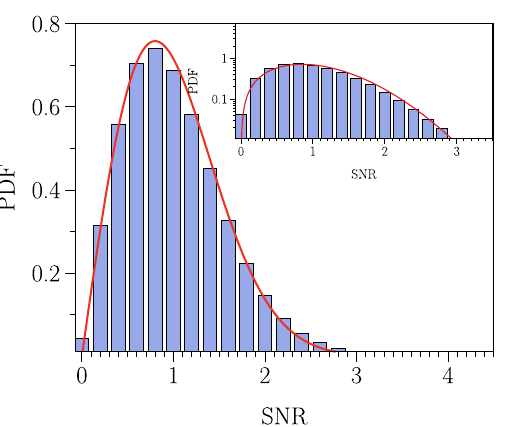
Figure 2. Probability distribution function (PDF) of signal to noise ratio ρ for processed background noise. The PDF of signal to noise ratio ρ for the processed background noise as well as Rayleigh distribution (red) with variance 0.67. The total time duration of the analyzed time series is about 637h. The PDF is estimated from ∼ 74 × 10 6 signal to noise ratio ρ of processed background noise. Each SNR is estimated for the 32 frequency bins between [ 30 − 500 ] Hz for a 10 s segments of time series in O2 and O3a run (see Supp. Info. for the GPS time of analyzed data). Inset the PDF is plotted on a log-linear scale compared to the right-tail of estimated and Rayleigh